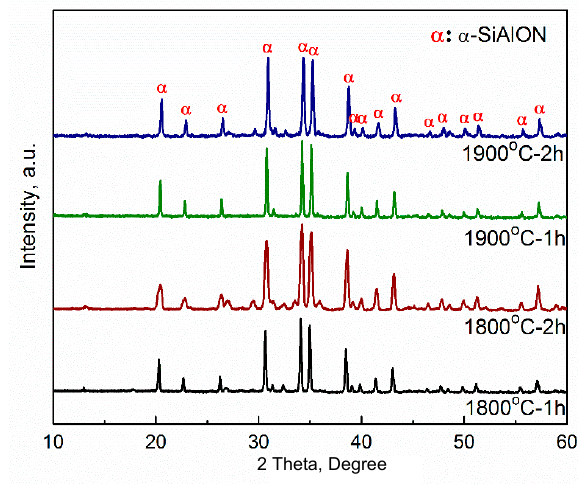
Figure 2. XRD patterns of porous α -SiAlON samples fired at different conditions.